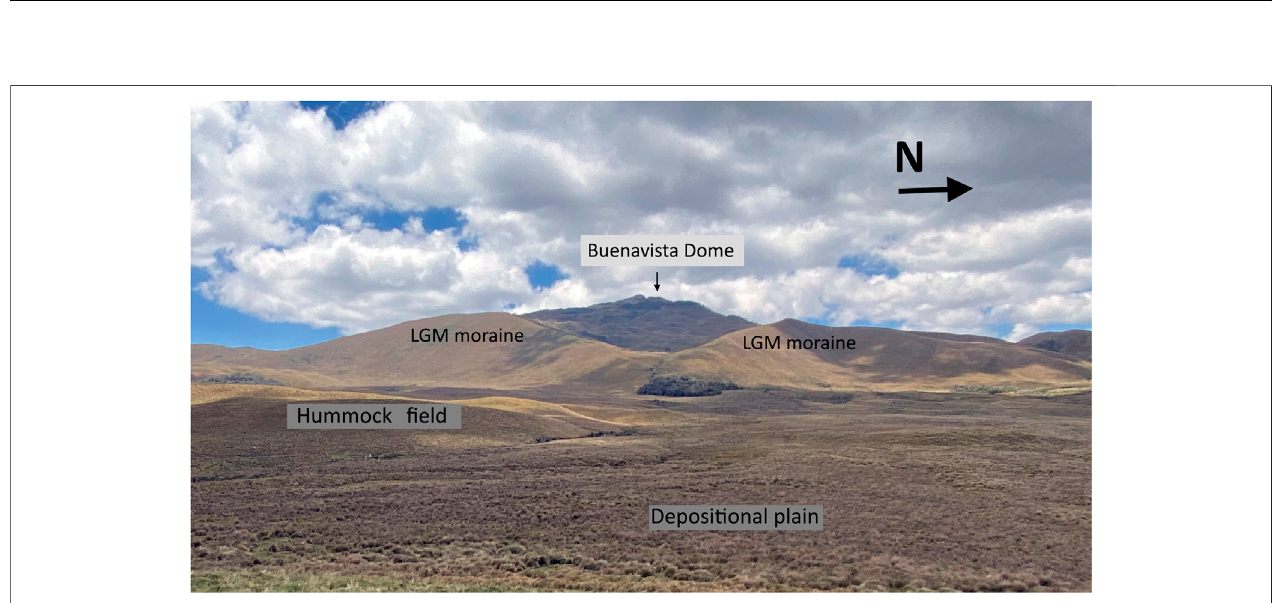
Frontiers in Earth Science |